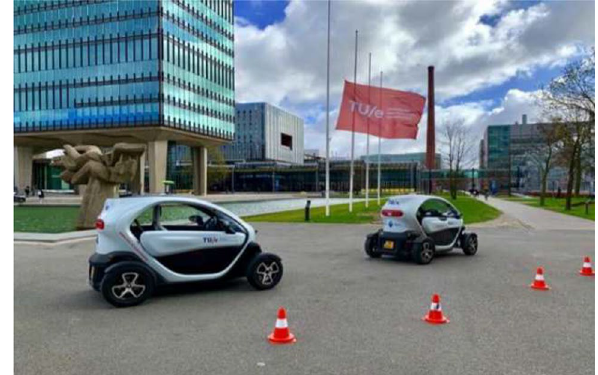
Fig. 1 i-CAVE platooning with Renault Twizy